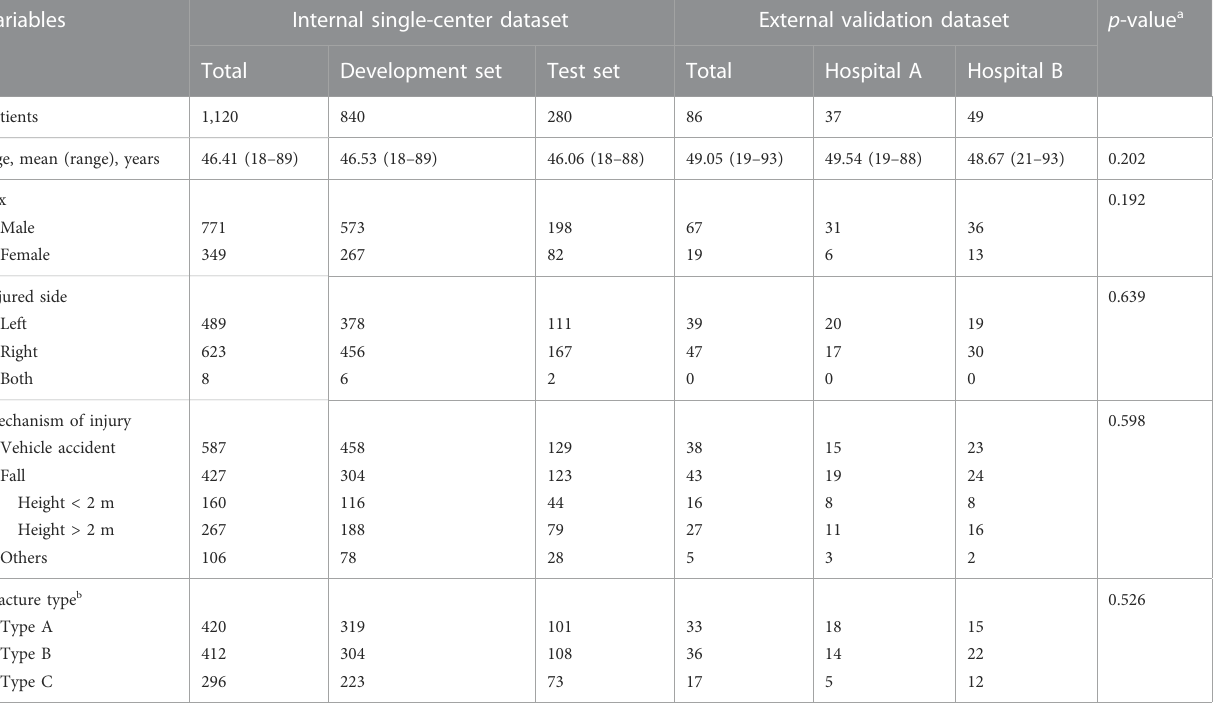
sets (Figure 3). The gradient-weighted class activation mapping (Grad-CAM) method was applied to visualize the probable AF regions of different fracture types determined by the DL model (Supplementary Figure S1) (Selvaraju et al., 2017).